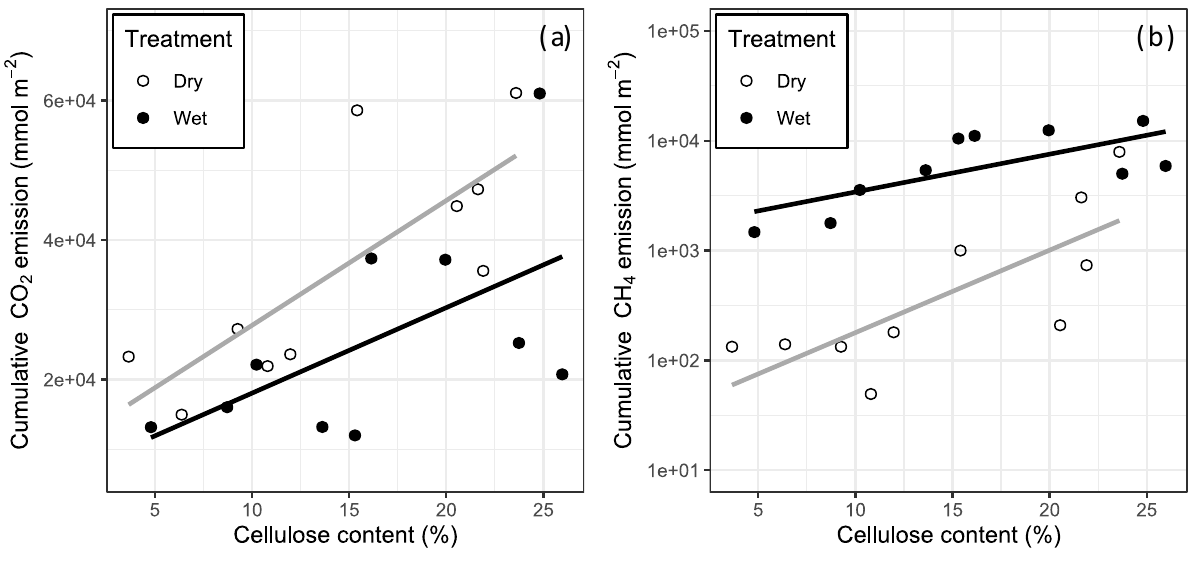
Figure 3. The cumulative emission of (a) CO 2 and (b) CH 4 [log10 scale] from peat monoliths versus peat ADF-cellulose contents under two experimentally induced water levels (“wet” or “dry”, i.e. water levels at 0 cm and 15 cm below the peat surface). Cumulative CO 2 and CH 4 emissions were estimated over a 84-day period by constructing AUC curves using biweekly flux